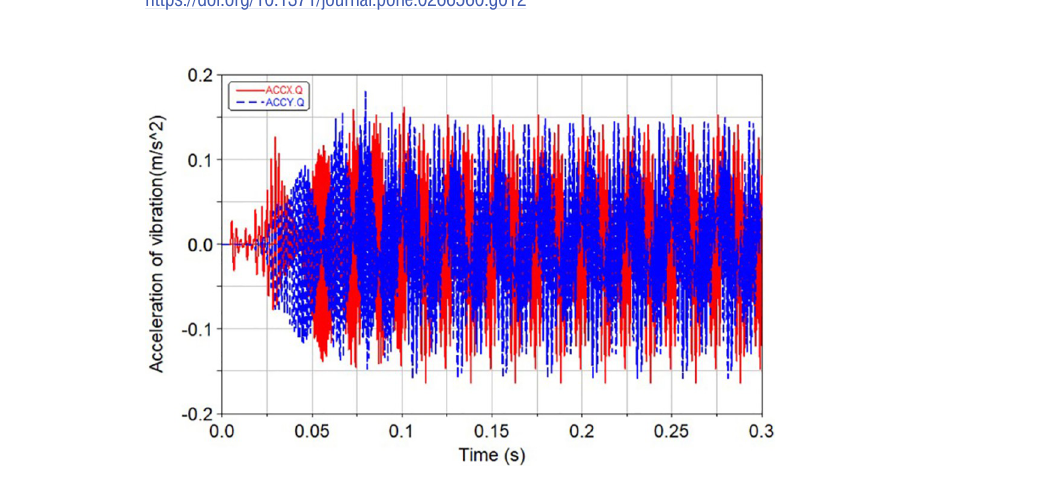
Fig 13. Vibration response during balanced gear